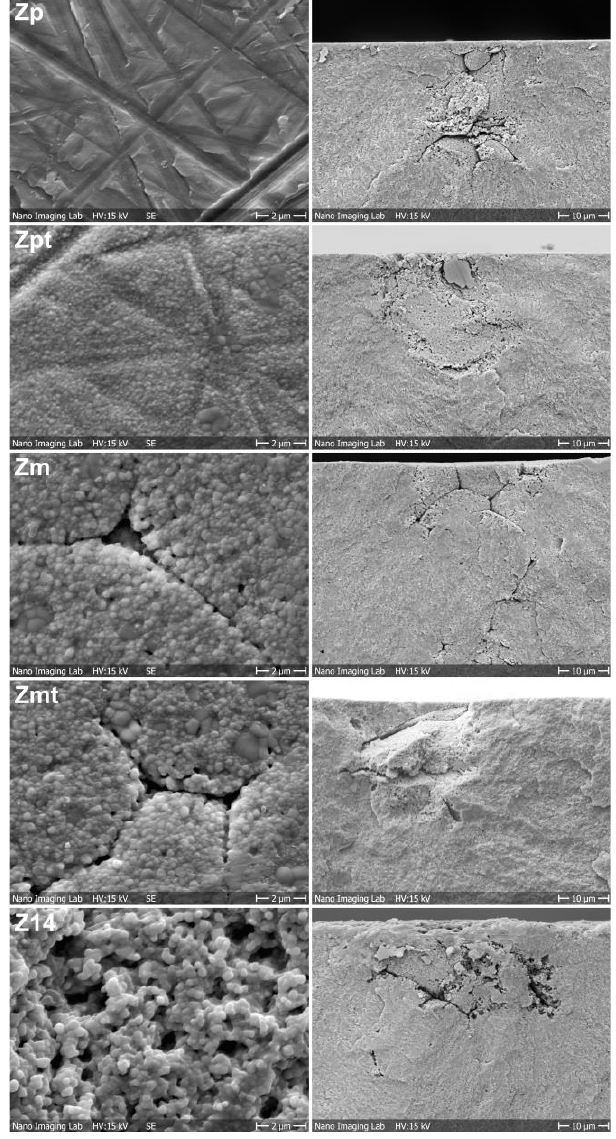
Figure 3. Scanning-electron-microscopy images of surface treatments of groups Zp, Zpt, Zm, Zmt and Z14 in left column. The fracture initiation site after conducting biaxial flexural strength testing for the respective group is displayed in the right column.